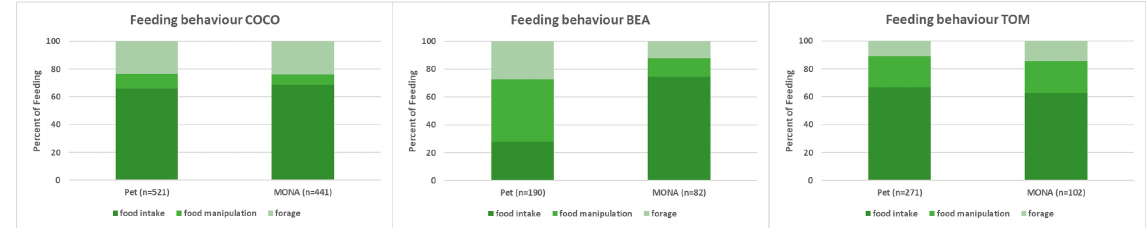
Figure 2. Comparison of the activity budgets while housed as pets (left) and after living at MONA for about 10 years (right) for ( a ) Coco, ( b ) Bea and ( c ) Tom.